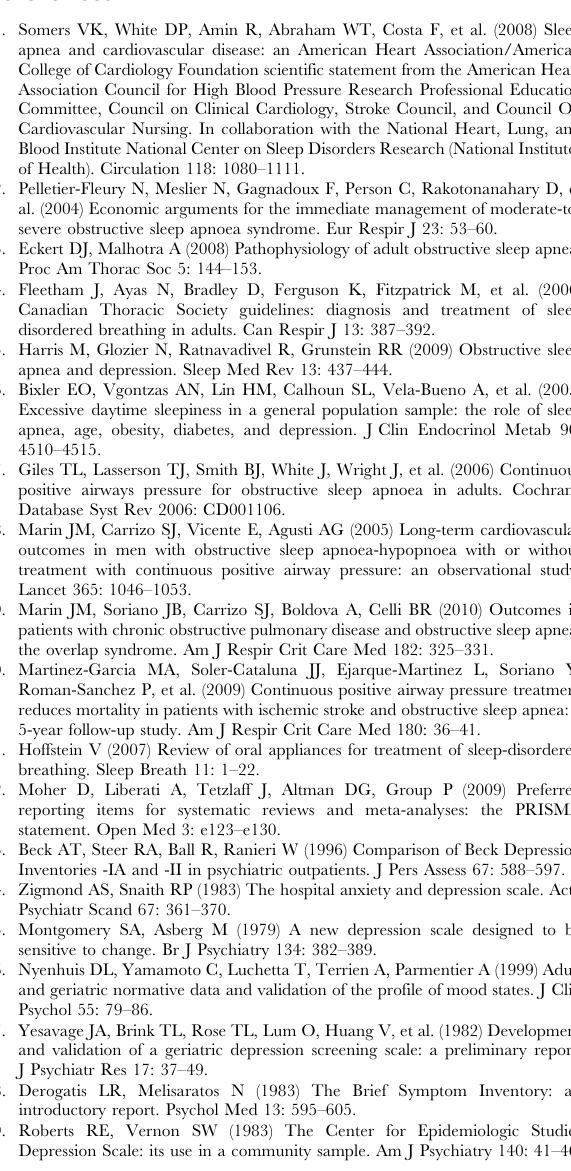
Figure S1 CPAP study forest plot stratified by study design. Data were calculated using a random effects model. Studies were stratified by study design: parallel versus crossover. Boxes are SMDs, and lines are 95% CIs. The vertical solid line represents no difference between CPAP and control. Values to the right of the solid line favor CPAP benefit. Pooled SMDs and 95% CIs are represented by the diamond shapes. Figure S2 Funnel plot of published studies. The standard error (s.e.) of the SMD is plotted versus the SMD. Larger studies cluster at the top of the pyramid, while smaller studies are in the outer lower